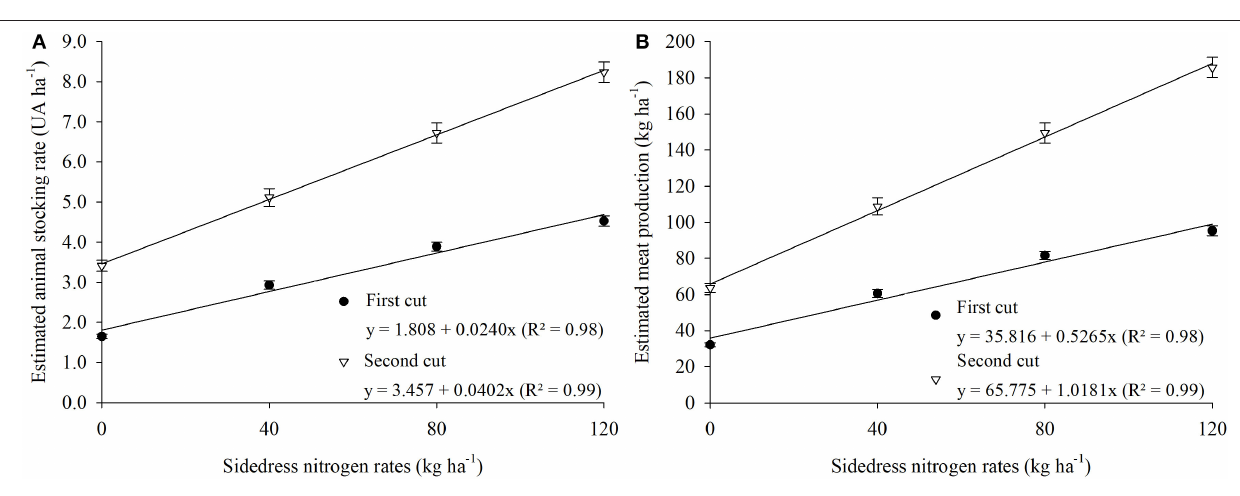
FIGURE 5 | Estimated animal stocking rate (A) , and estimated meat production as affected by sidedress nitrogen rate (B) . Average of three growing seasons. Stocking rate and meat production in the fall-winter period, after rice harvest. Each data point is the mean of 24 replicates (two cropping systems, four blocks, and three growing seasons) and associated error bar is ± one